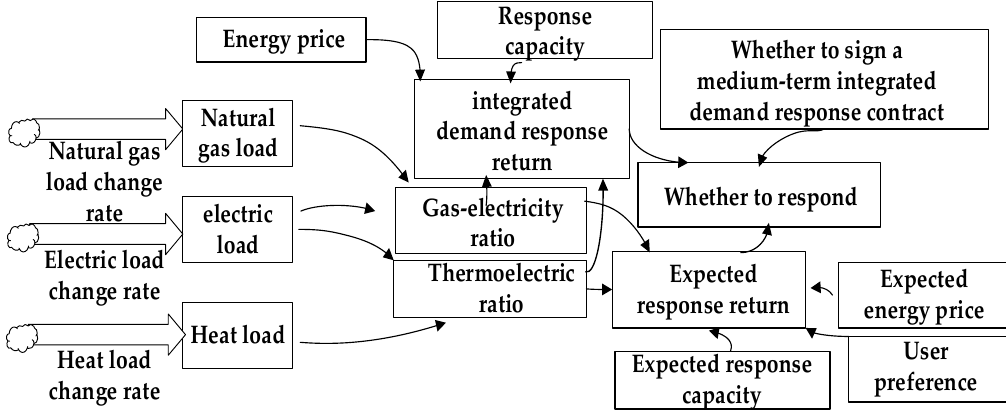
Figure 5. Short-term integrated demand response simulation module stock flow chart.